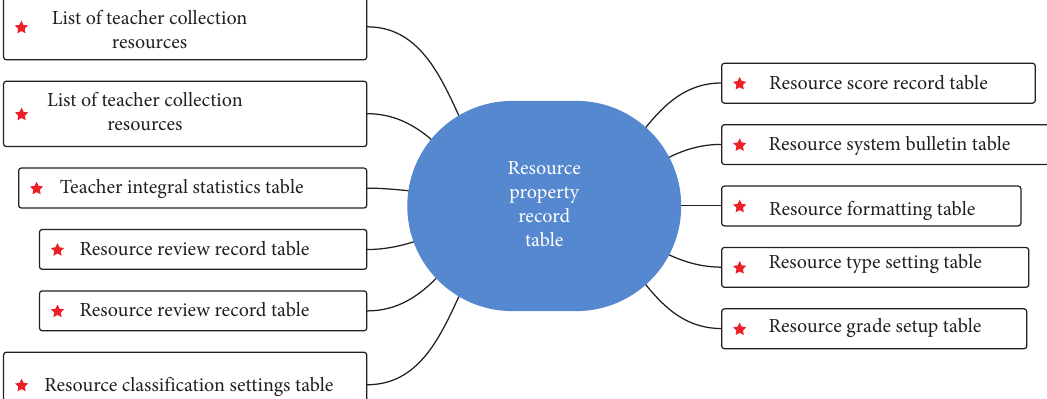
Figure 7: Data table relationship diagram.